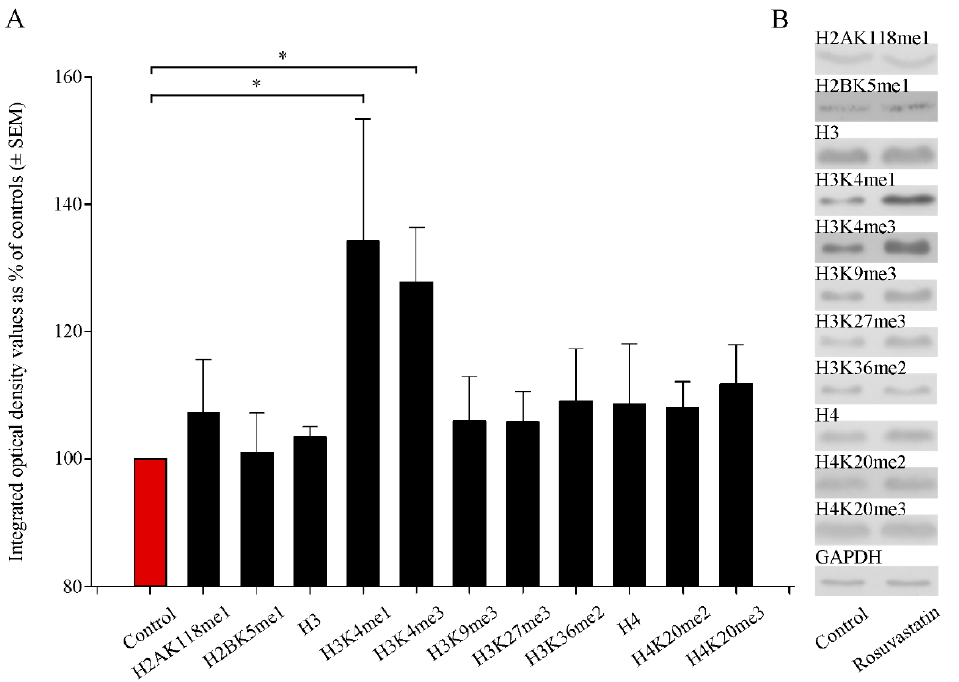
Figure 6. Quantitative Western blot analyses of histone methylation patterns in newborn rat brains. ( A ) Protein contents from the vehicle-treated controls and RST-treated newborns were determined and assayed by Western blot. Gel-loaded protein samples were separated by gel electrophoresis, transferred to nitrocellulose membranes, and assayed for immunoreactivity using antibodies that recognize different histone methylations. Grayscale digital images of the immunoblots were scanned and processed at identical settings to allow comparisons between Western blots from different samples. Integrated optical density values were calculated as the percentage of the vehicle-treated control values that had been normalized to the internal standard GAPDH. Prenatal RST exposure induced a general increase in the Lys-methylated sites of several histone proteins. Quantitative analysis showed that H3 histone mono- and tri-methylation at Lys 4 (H3K4me1 and H3K4me3) increased significantly (134.3% and 127.8% of vehicle-treated controls, respectively). ( B ) Representative Western blot images of immunoreactivity toward antibodies specific to the methylation sites and states, together with the GAPDH immunoreactive bands that served as the internal standards. Data were analyzed with the Mann–Whitney rank–sum test. Values are presented as the means ± SEM from at least 5 separate experiments, where p < 0.05 is considered significant. (* p <